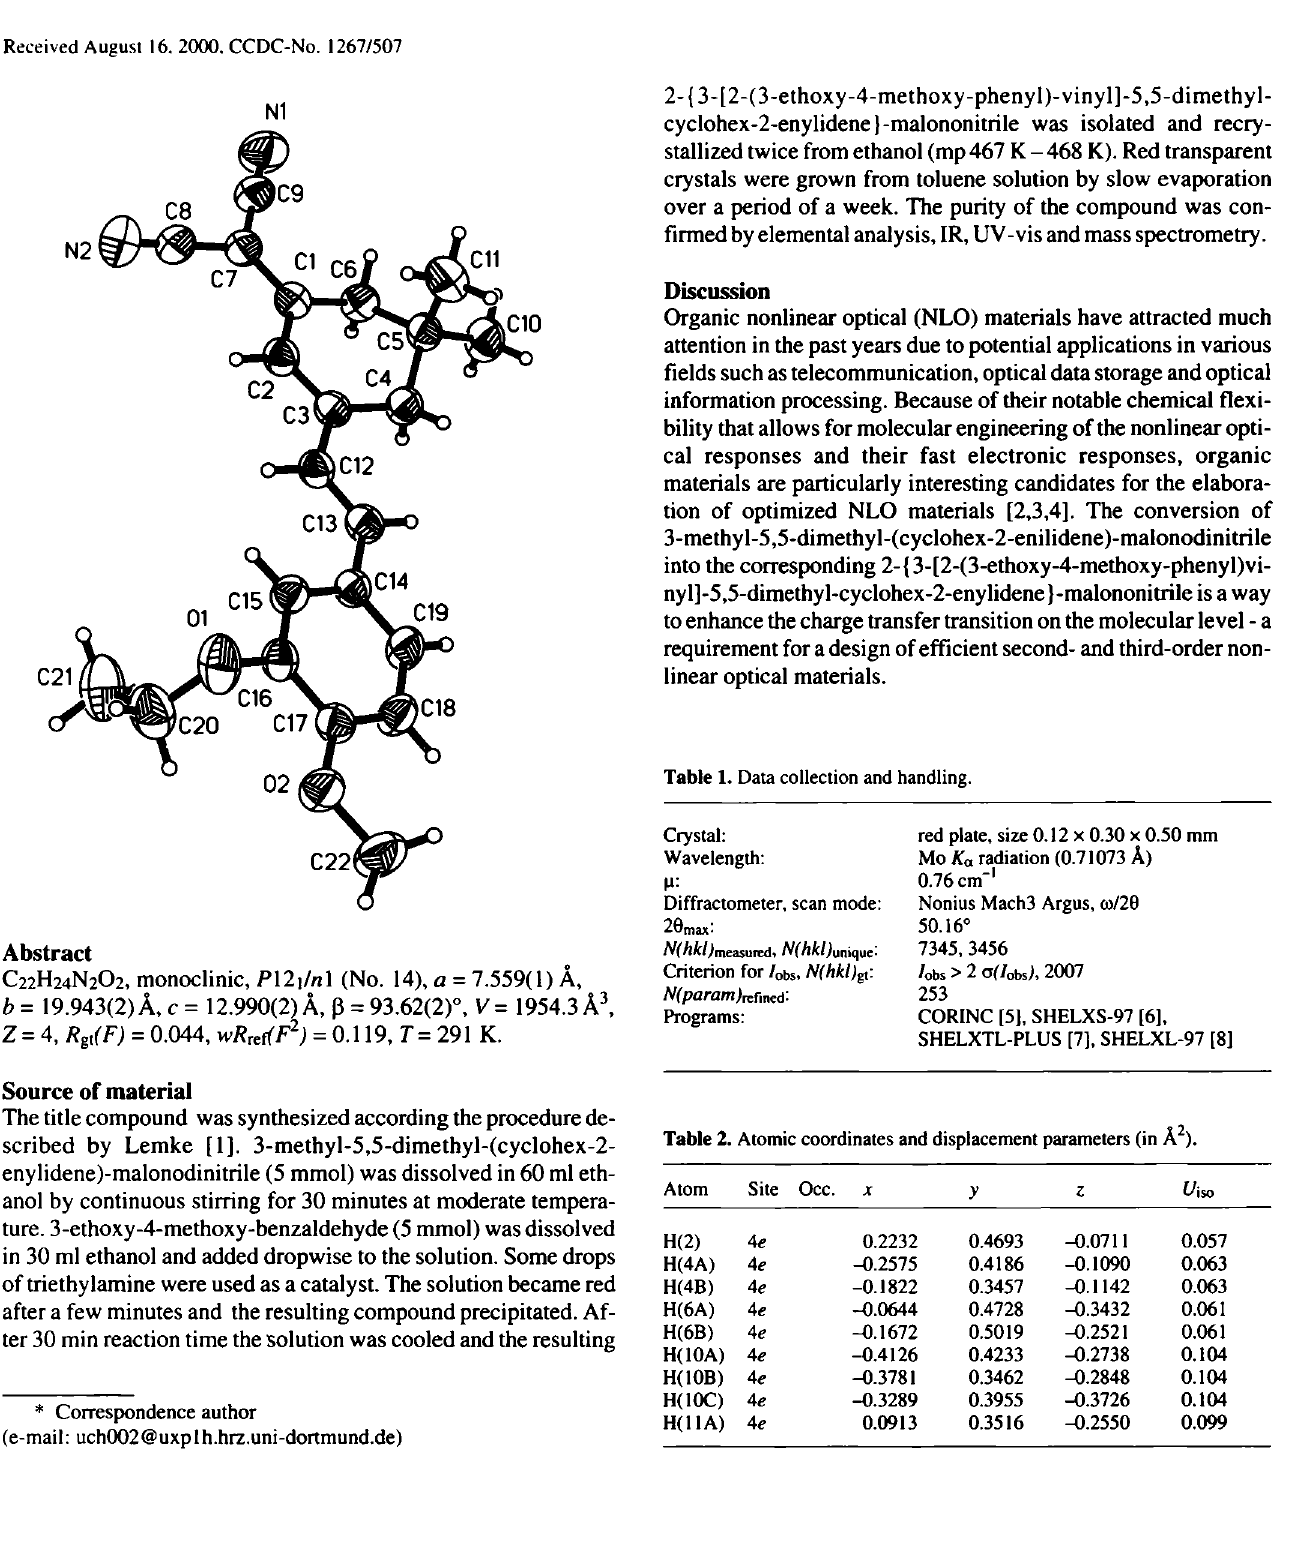
Table 2. Atomic coordinates and displacement parameters (in Ä 2